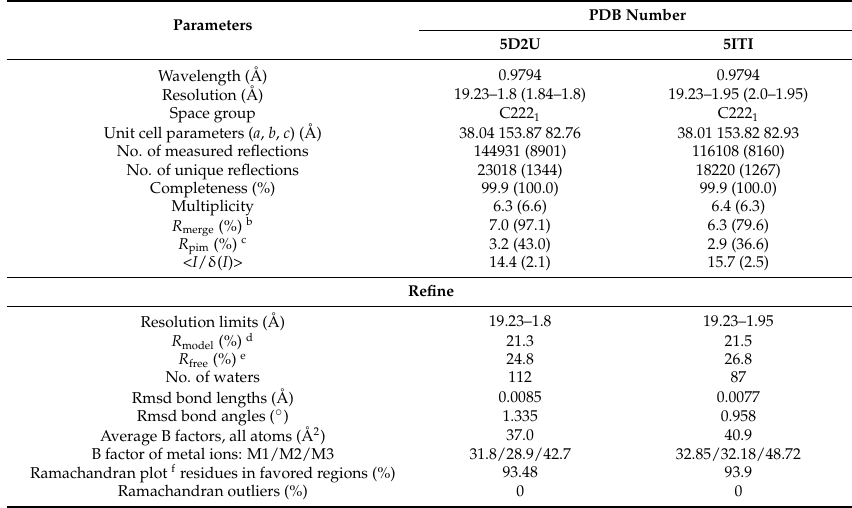
Table 1. Crystallographic data collection and refinement statistics a .